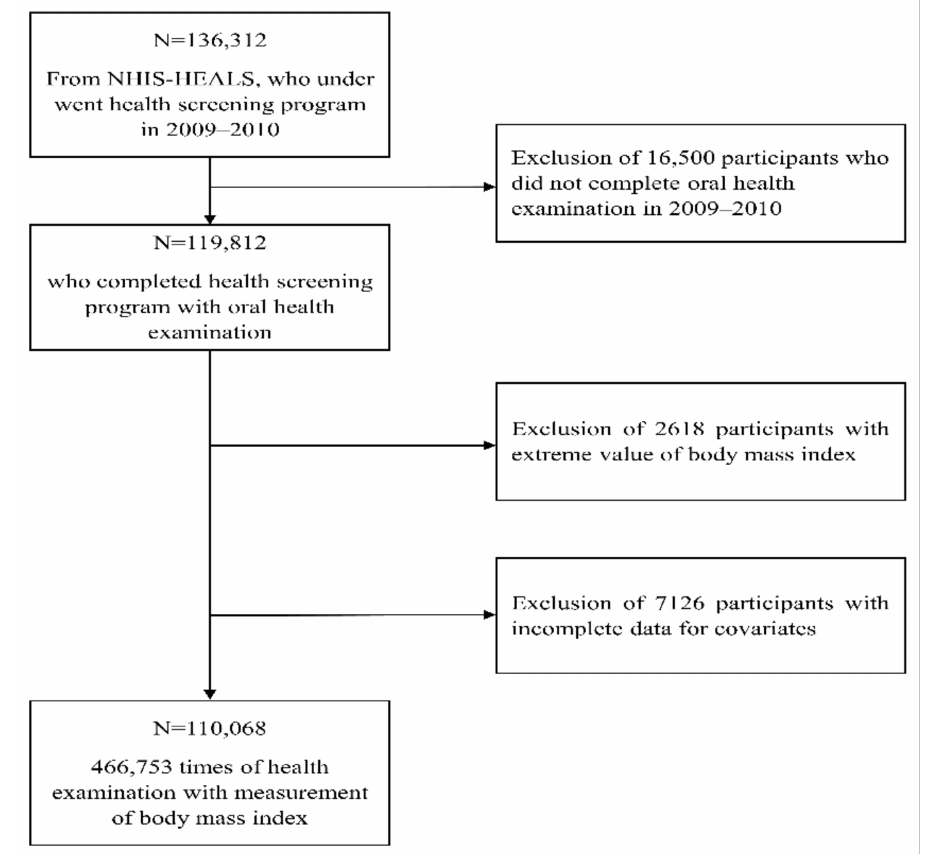
Figure 1. Flow chart showing the inclusion and exclusion criteria. NHIS–HEALS, National Health Insurance Service-National Health Screening Cohort in